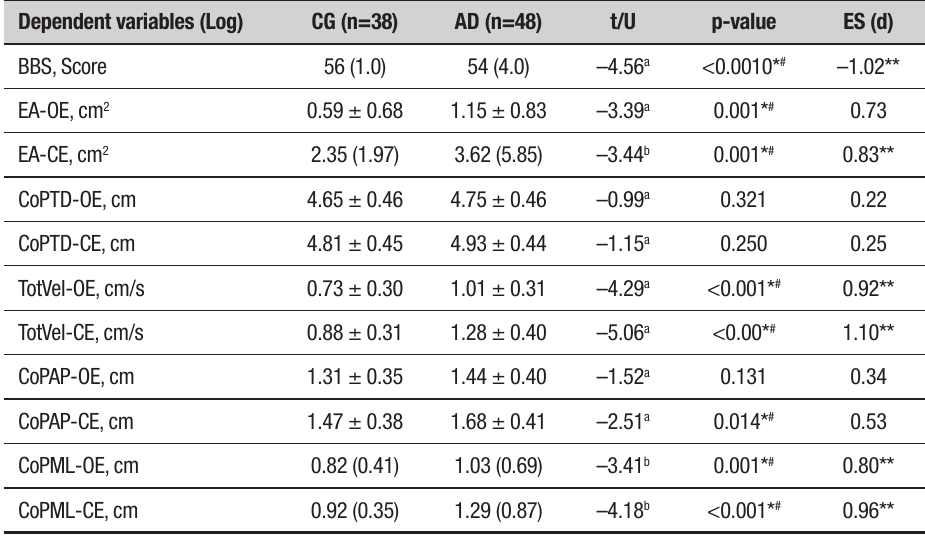
Table 3. Comparison between groups in the log stabilometry measurements (WBB) and balance (BBS). Dependent variables (Log)